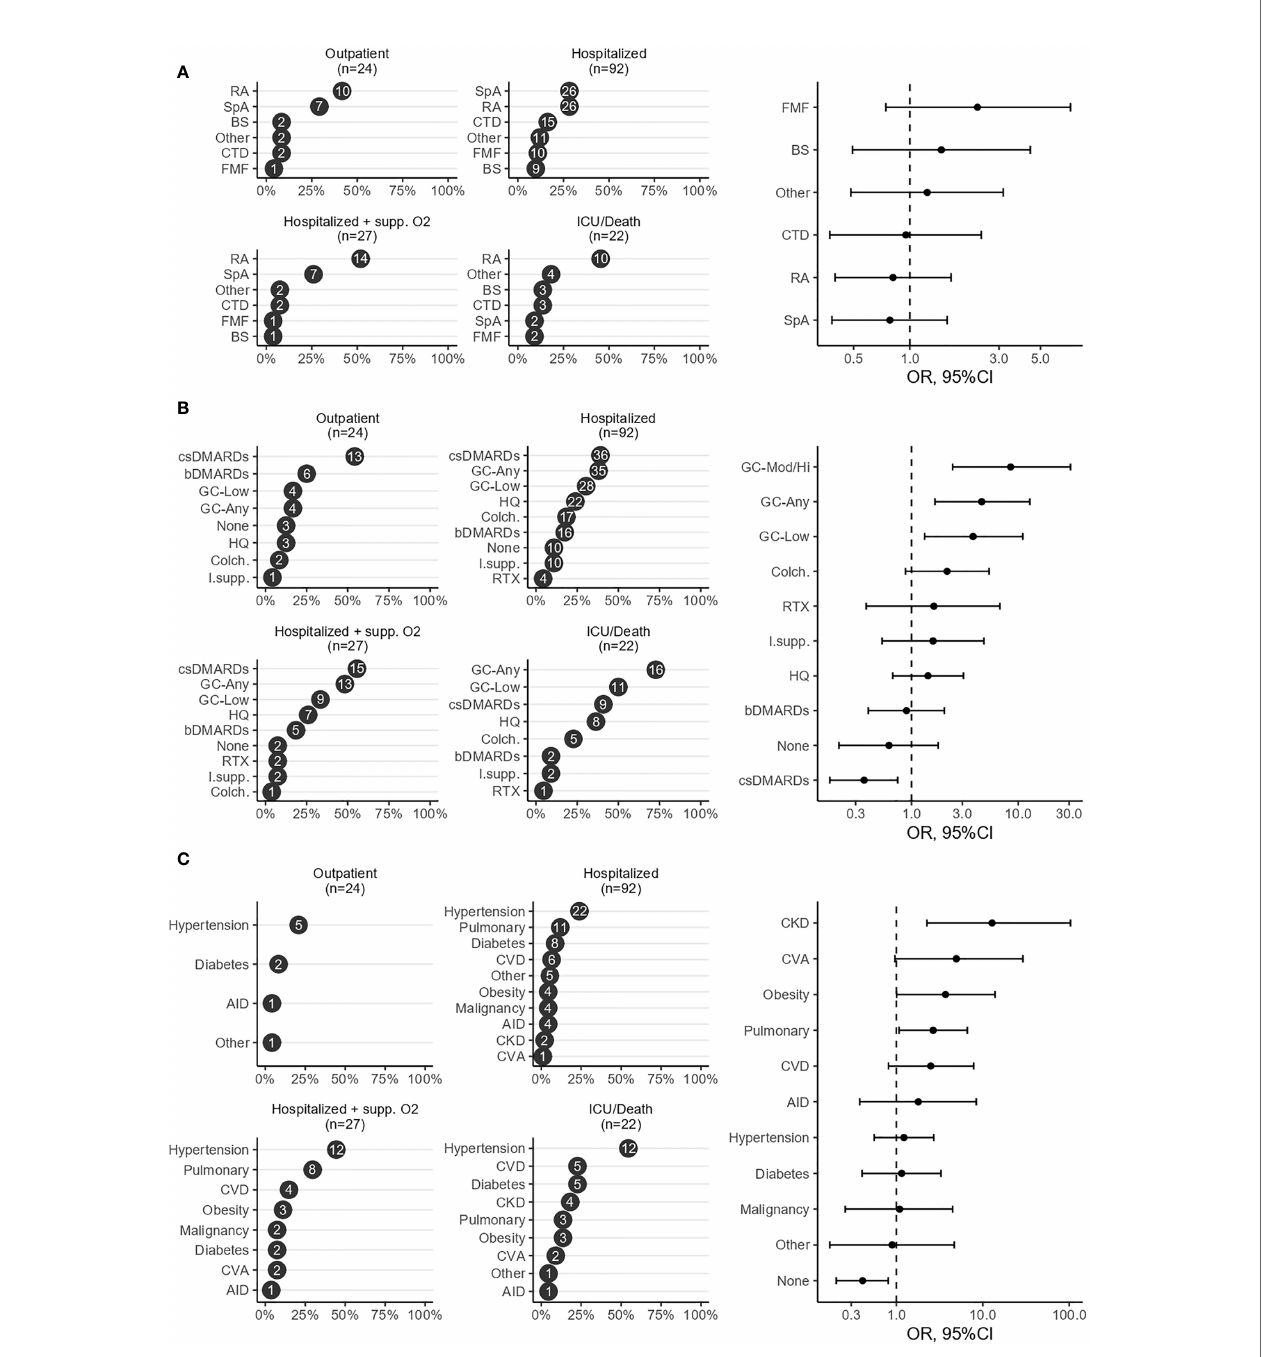
FIGURE 1 | Risk factors of a worse COVID-19 outcome in patients with in fl ammatory rheumatic diseases. Figure illustrates the ranked proportions of IRD diagnoses (A) , IRD treatments (B) , and comorbidities (C) for each outcome category and the association of each with a worse outcome, analyzed using proportional odds logistic regression where the dependent variable was the 4-level ordinal outcome and the independent variable of interest was the type of IRD treatment, comorbidity or primary IRD diagnosis. High/moderate glucocorticoid dose (GC-Mod/Hi) was de fi ned as a daily dose of ≥ 7.5 mg prednisolone. csDMARDs included methotrexate, sulfasalazine, le fl unomide, immunosuppressives included mycophenolate mofetil, tacrolimus, azathioprine and bDMARDs included tumor necrosis factor inhibitors, abatacept, anakinra, secukinumab and tocilizumab. AID, additional immune disorder; bDMARDs, biologic DMARDs; BS, Behc ̧ et syndrome; CKD, chronic kidney disease; Colc., colchicine; csDMARDs, conventional synthetic DMARDs; CTD, connective tissue disease; CVA, cerebrovascular accident; CVD, cardiovascular disease; DMARDs, disease-modifying antirheumatic drugs; FMF, Familial Mediterranean fever; GC, glucocorticoid; ICU, intensive care unit; IRD, in fl ammatory rheumatic disease; I.supp., immunosuppressives; HQ, hydroxychloroquine; RA, rheumatoid arthritis; RTX, rituximab; SpA,